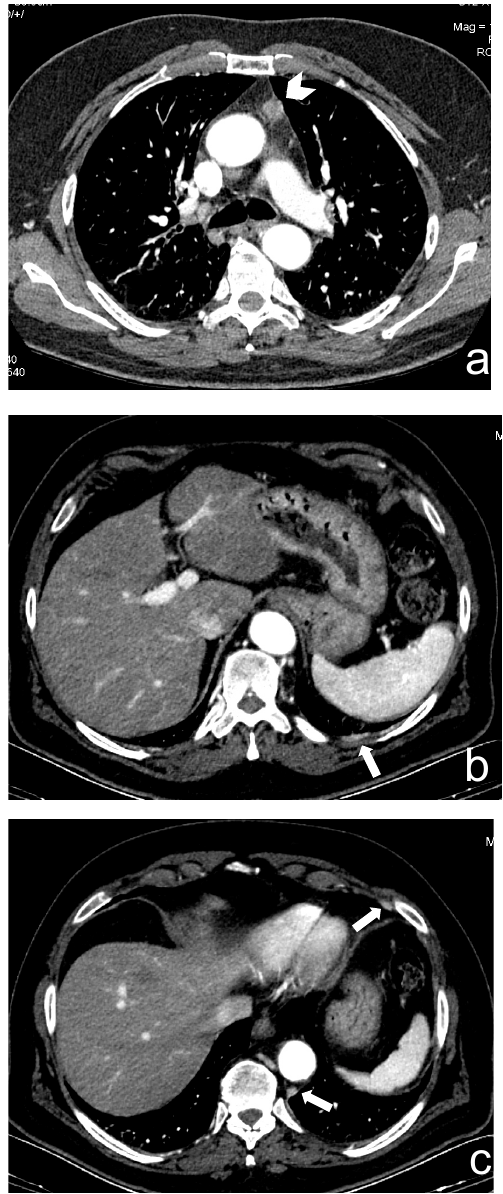
Figure 1. ( a – c ) A 66-year-old man who underwent robotic surgery in March 2016 for a thymic basaloid carcinoma (stage I, arrowhead in ( a )). In June 2020, small bilateral pleural metastatic lesions appeared without pleural effusion (arrows in ( b , c